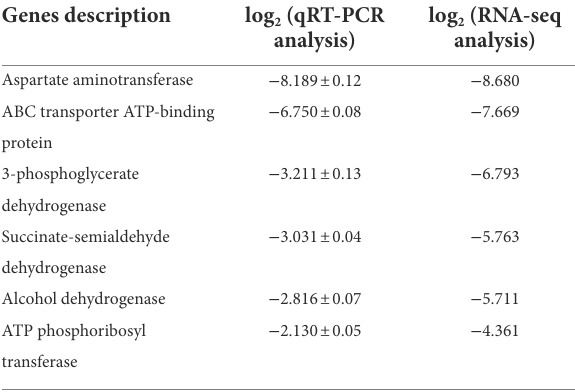
TABLE 2 Assay of the transcription of genes by the method of qRT-